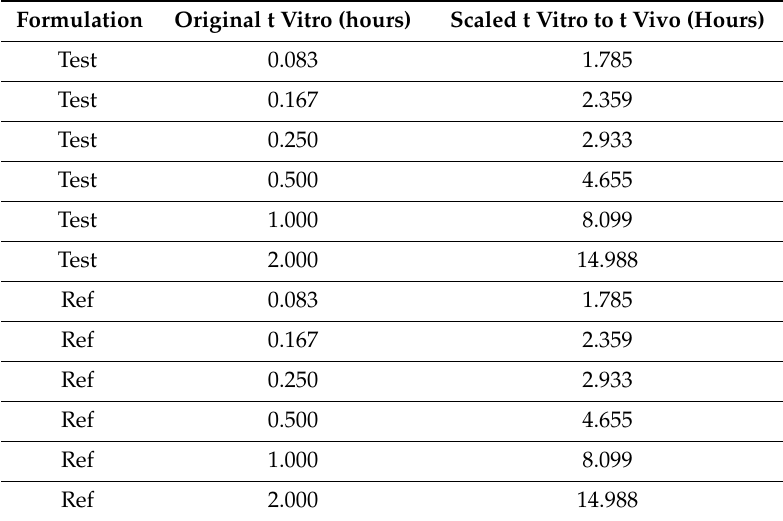
Table 4. Vitro times scaled to vivo times using the Levy plot.